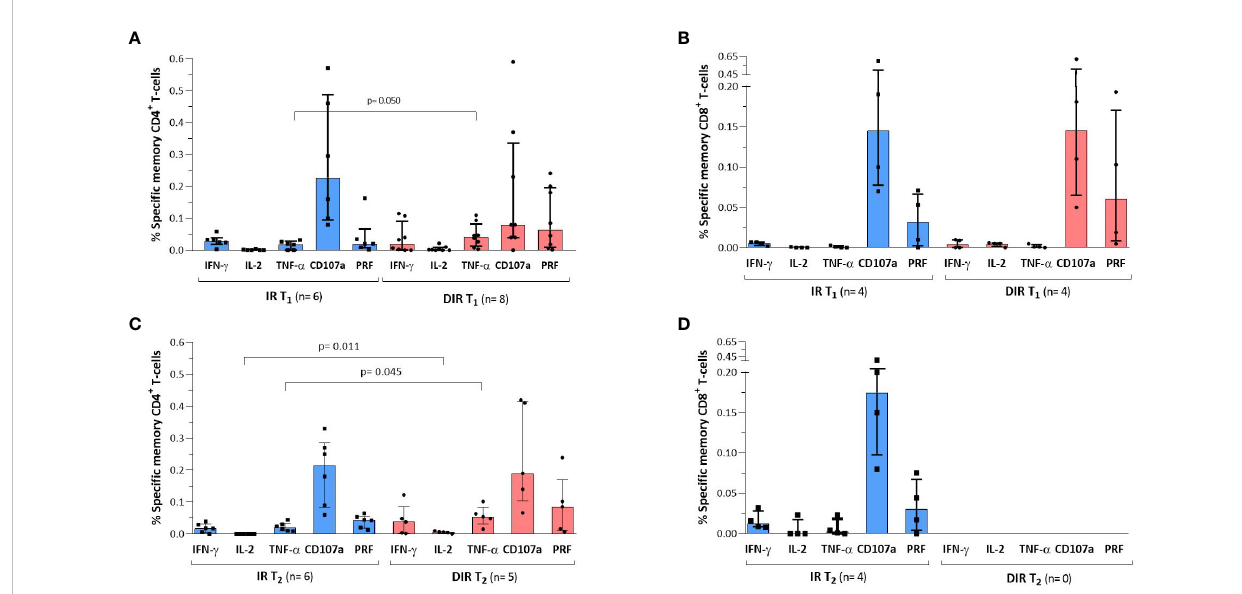
FIGURE 7 SARS-CoV-2 speci fi c CD4 + and CD8 T + cell responses after (A, B) one (T1) and (C, D) a median of 5.5 months (T2) after the two mRNA vaccine doses according to the group of participants (IR, immune 626 responders. DIR, discordant immune